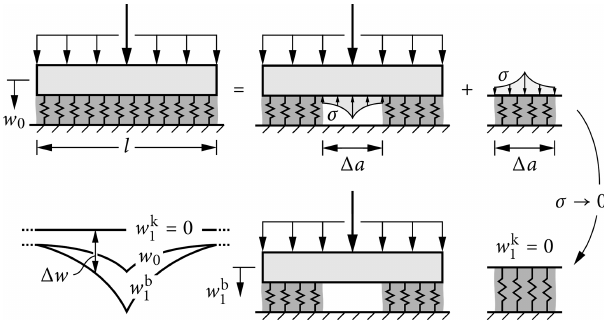
Figure 4. Graphical representation of the mode I crack opening in- tegral. An uncracked snowpack can be represented by removing a part of the weak layer and applying virtual stresses to both the slab and the removed weak-layer segment such that they are deformed as in the original configuration ( w 0 ). Reducing the virtual stresses to zero quasi-statically increases the beam deformation ( w b ), relaxes 1 the weak layer ( w k ) and finally yields the cracked configuration. 1 The work done by the virtual stresses (integral of σ(cid:49)w on (cid:49)a ) cor- responds to the total potential energy difference between uncracked and cracked